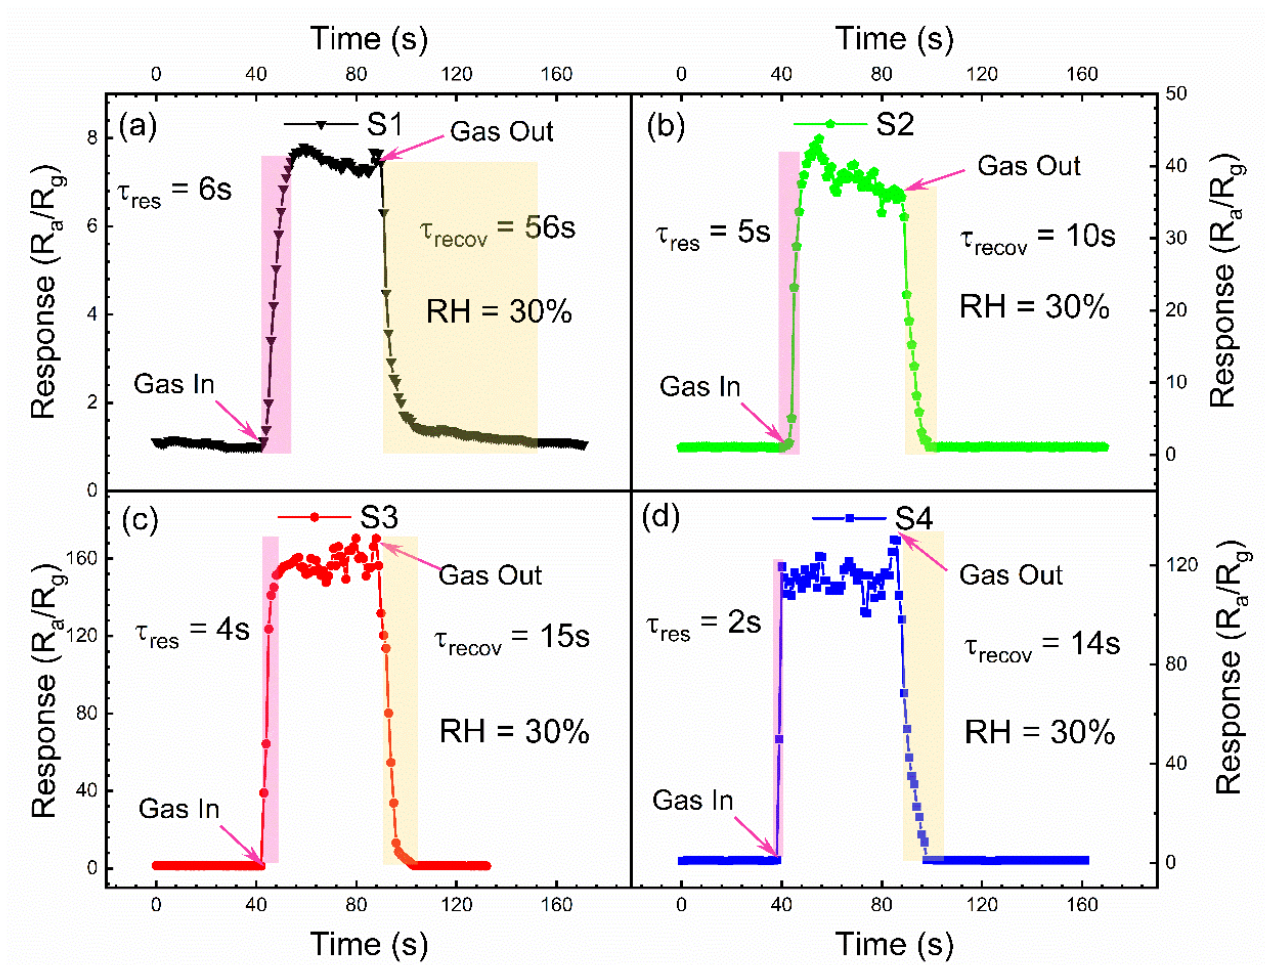
Figure 5. The dynamic response curves of as-obtained samples with time to 100 ppm IPA. ( a ) S1; ( b ) S2; ( c ) S3; ( d ) S4.